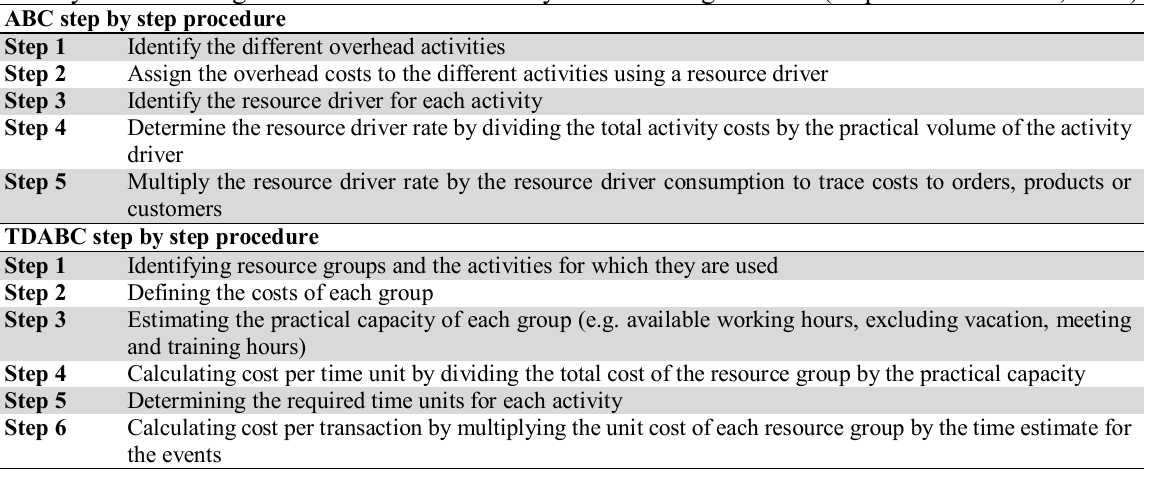
Activity-based costing versus time-driven activity based costing. Source: (Kaplan & Anderson, 2007)